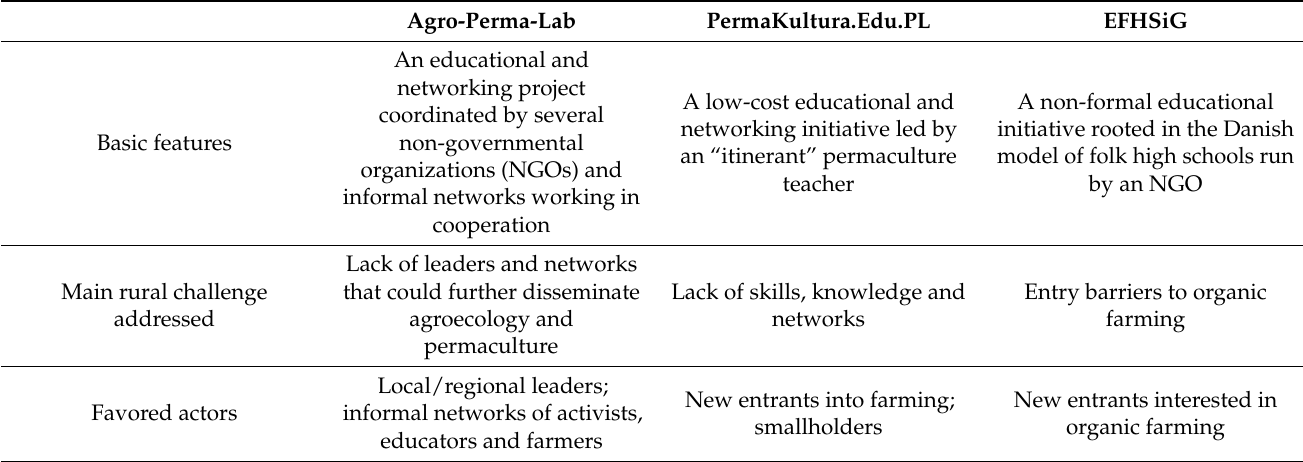
Table 1. Assessment of the three initiatives against selected